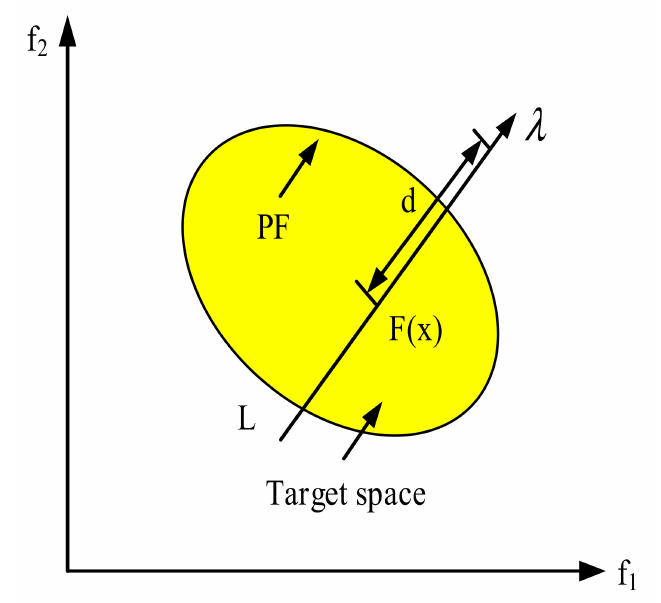
Figure 2. Schematic diagram of the boundary